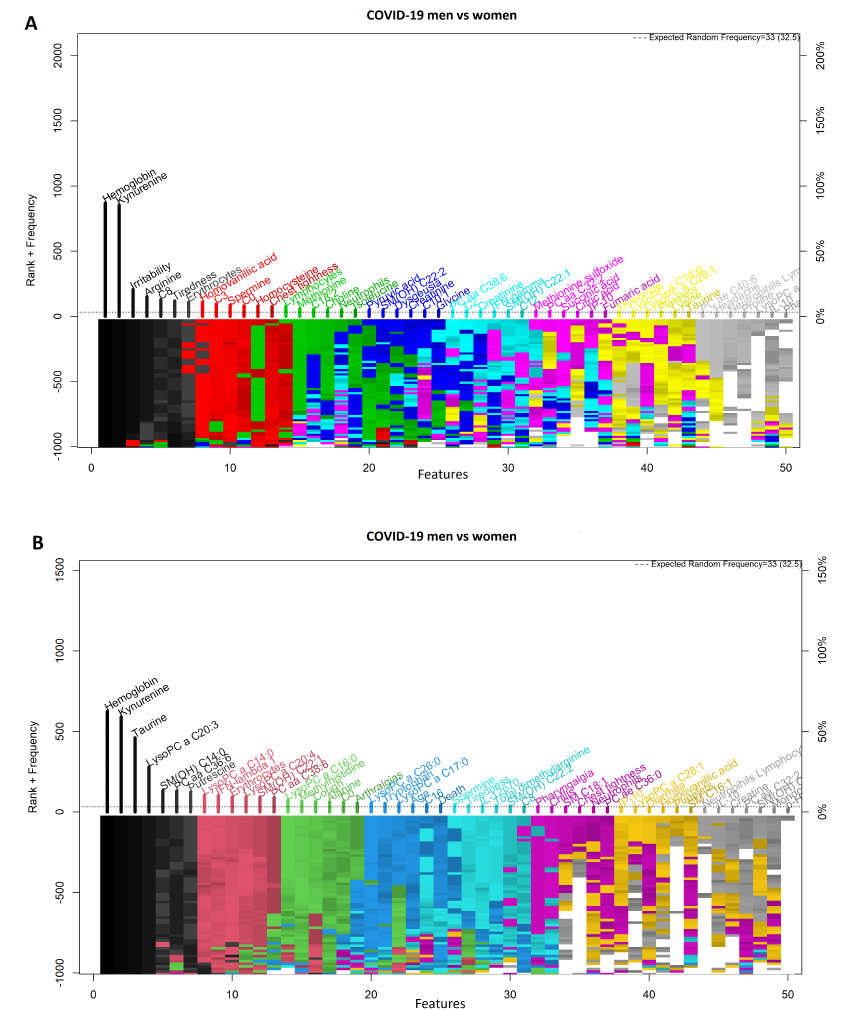
Figure 2. Feature–rank stability in 1000 models, for the classification of men and women with COVID-19. ( A ) Logistic regression model and ( B ) Support Vector Machine model. The ”y positive” axis shows the number of times each feature was included in a given model (the frequency ranking). The ”y negative” axis shows the color coded rank of each feature as each model was generated. The ”x” axis shows the features ordered by rank. The starting color for each feature is assigned accordingly to the feature descending rank (from black down to